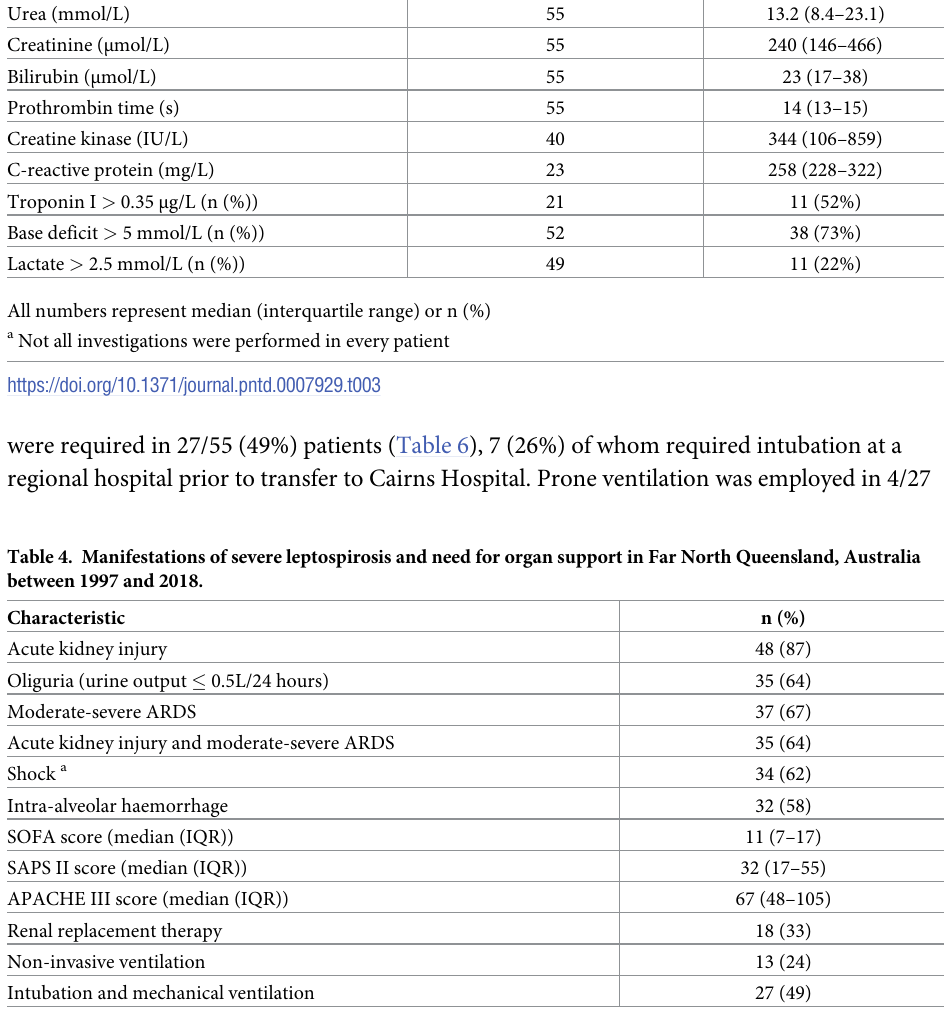
Intubation and mechanical ventilation 27 (49) Abbreviations: ARDS, acute respiratory distress syndrome; SOFA, Sequential Organ Failure Assessment; IQR, interquartile range; SAPS, Simplified Acute Physiology Score; APACHE, Acute Physiology Age Chronic Health Evaluation. Oliguria: Urine output � 0.5L/24 hours a defined as blood pressure < 90/60 mmHg despite appropriate intravenous fluid challenge and